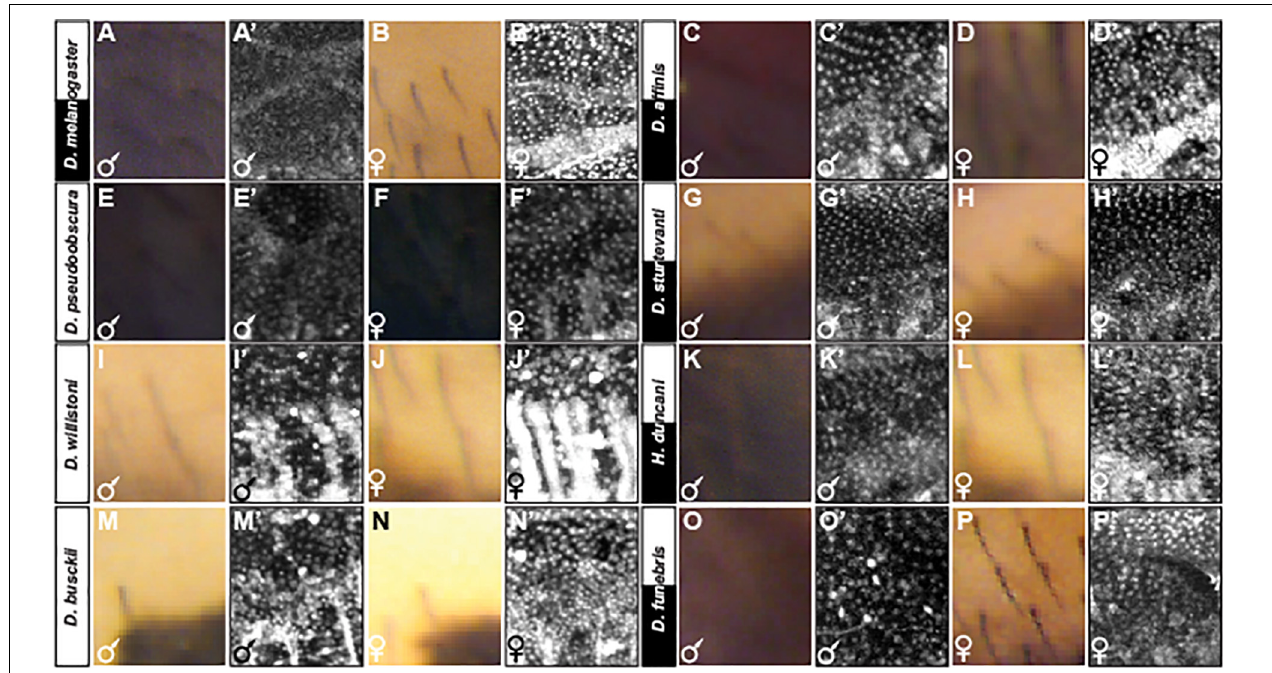
FIGURE 8 | Adult pigmentation phenotypes and P10 stage pupal Bab1 expression in a representative region of the A5 segment. (A) Male and (B) female tergite pigmentation, and (A’) male (B’) female Bab1 expression for D. melanogaster . (C) Male and (D) female tergite pigmentation, and (C’) male (D’) female Bab1 expression for D. affinis . (E) Male and (F) female tergite pigmentation, and (E’) male (F’) female Bab1 expression for D. pseudoobscura . (G) Male and (H) female tergite pigmentation, and (G’) male (H’) female Bab1 expression for D. sturtevanti . (I) Male and (J) female tergite pigmentation, and (I’) male (J’) female Bab1 expression for D. willistoni . (K) Male and (L) female tergite pigmentation, and (K’) male (L’) female Bab1 expression for H. duncani . (M) Male and (N) female tergite pigmentation, and (M’) male (N’) female Bab1 expression for D. busckii . (O) Male and (P) female tergite pigmentation, and (O’) male (P’) female Bab1 expression for D. funebris . Tergite pigmentation is dimorphic for D. melanogaster , D. affinis , D. sturtevanti , H. duncani , and D. funebris . Bab1 expression was dimorphic for D. melanogaster (little to no expression in males), while monomorphic for all other species examined here, including those that exhibit dimorphic